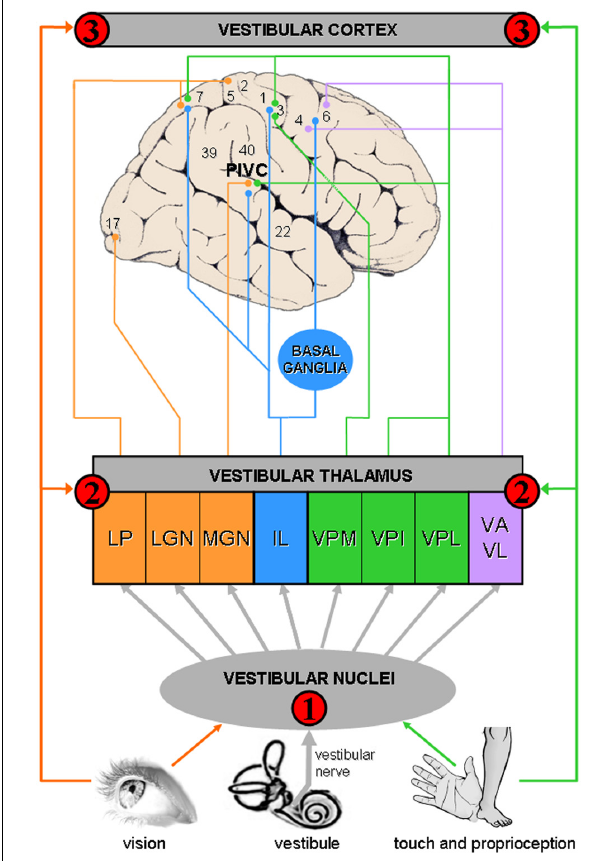
FIGURE 1 | Convergence of vestibular, visual, and somatosensory signals in vestibulo-thalamo-cortical structures. The schema summarizes animal and human data, showing multisensory convergence in three vestibular relays (see also Table 1 for details): Vestibular signals are first processed in the vestibular nuclei in the brainstem, a region that is highly